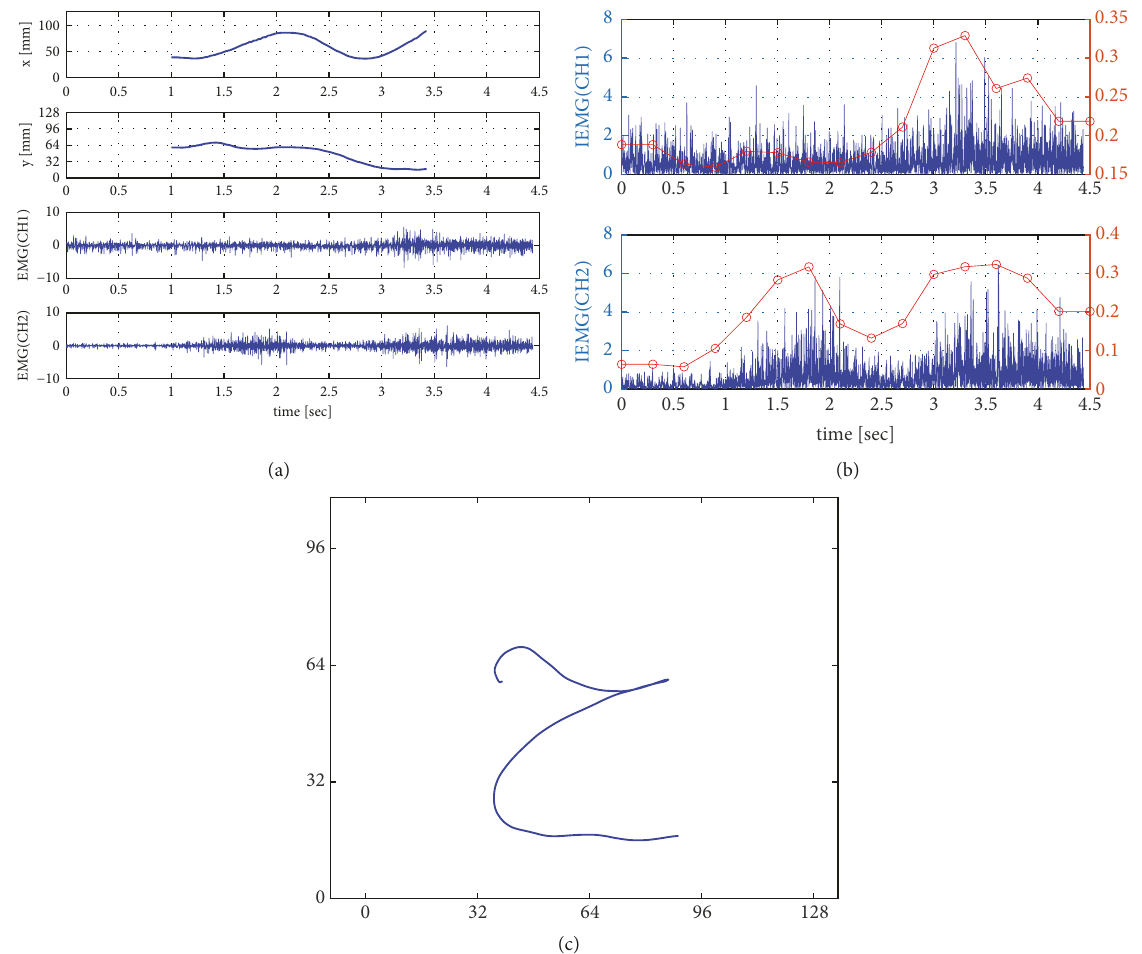
(cid:2) Figure 2: The letter, , «HA». (a) Movement on the plane ( x , y ) and EMG signals. (b) IEMG signals. (c) Form.